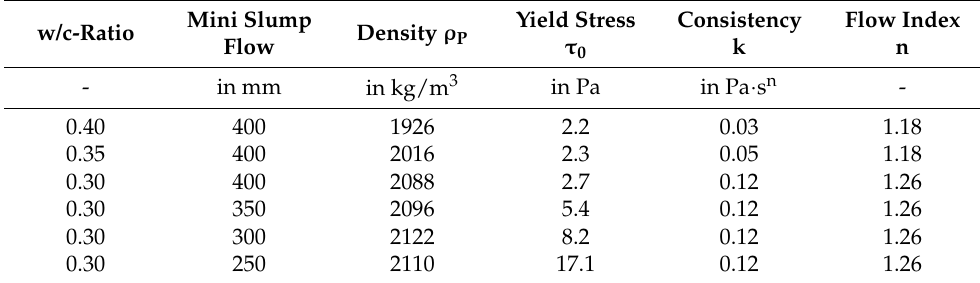
Table A1. Results of the density and rheological measurements according to